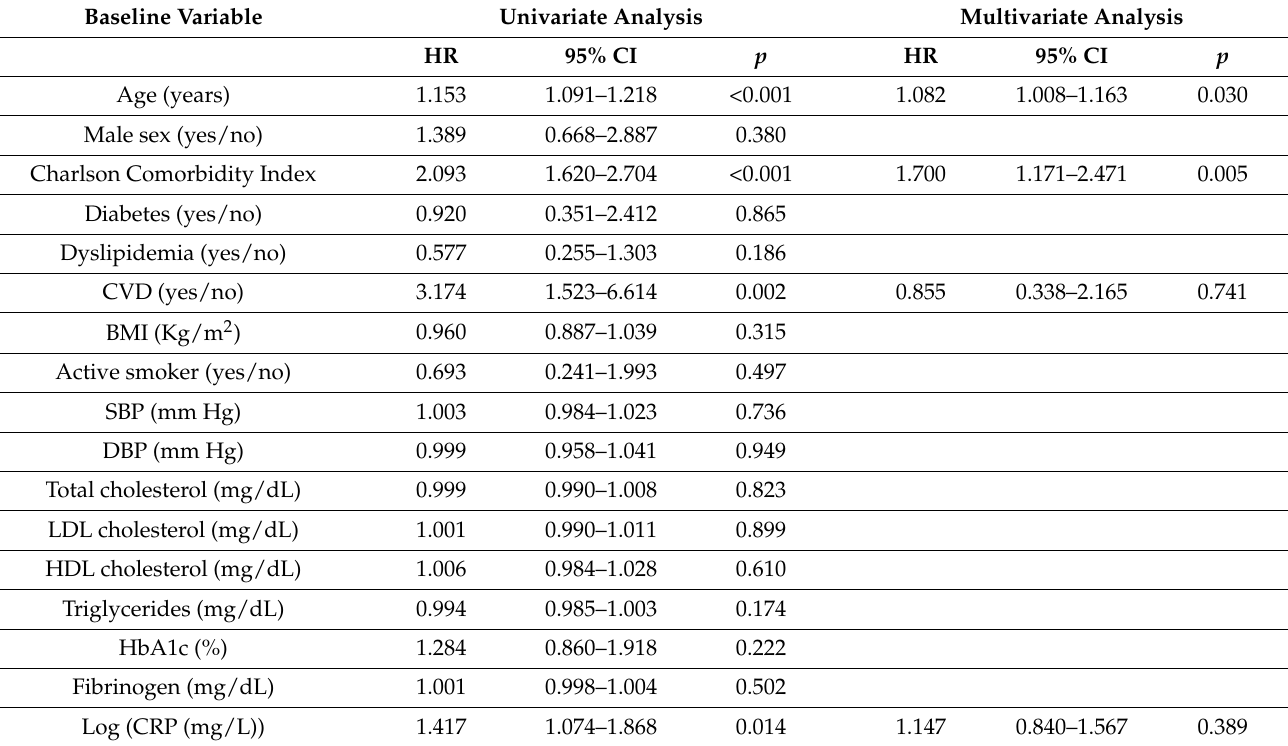
Table 3. Variables associated with composite endpoint by univariate and multivariate Cox regression analysis. Baseline